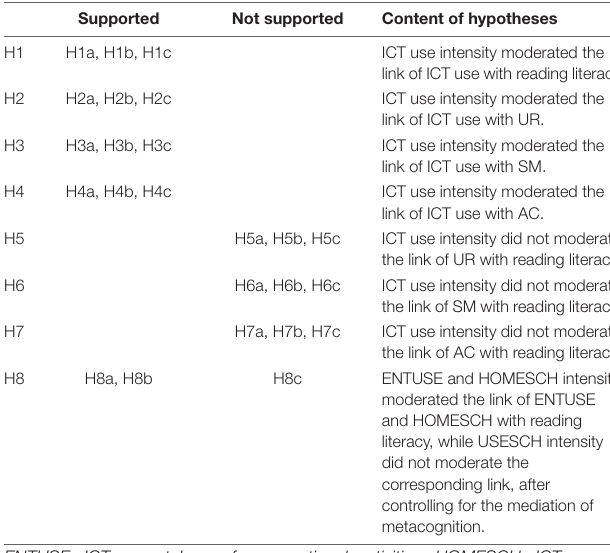
TABLE 8 | The moderated mediation analysis across USESCH intensity. TABLE 9 | The summary of our hypotheses